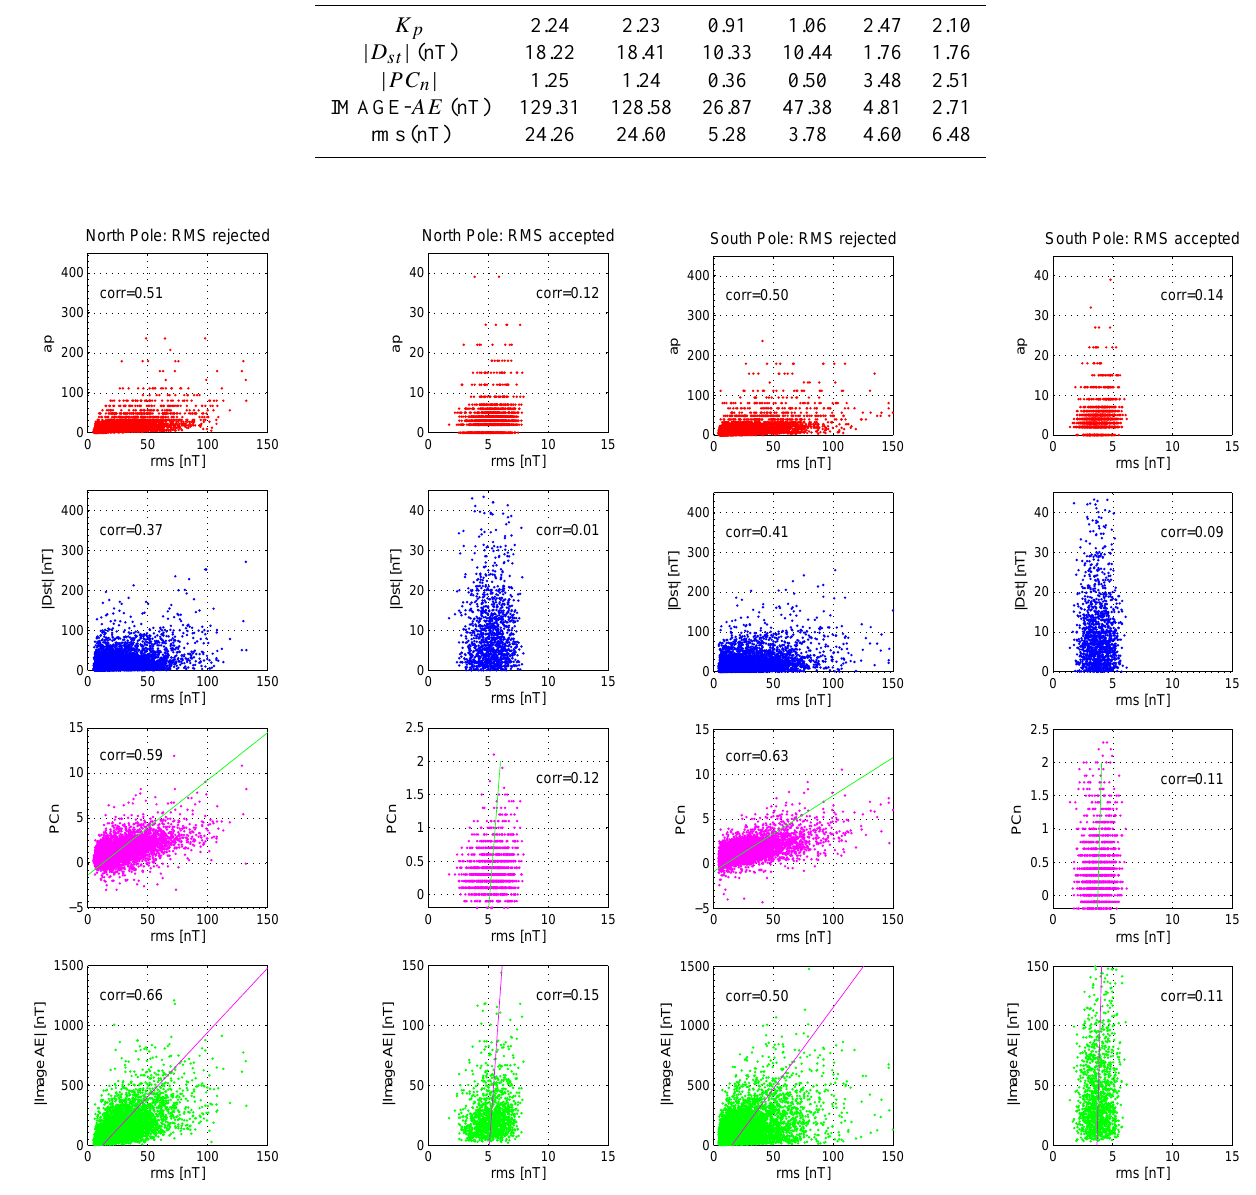
Fig. 2. Correlation analysis between the rms values of the residuals and activity indices a p ( K p ), D st , PC n , and IMAGE- AE at the north (left) and south pole (right). Left columns for “normal” passes, and in the right columns those accepted by the rms criterion for very quiet orbits. Each diagram shows the index versus the rms value across the polar track, the regression line is added. The correlation coefficients R (“corr”) are listed in the